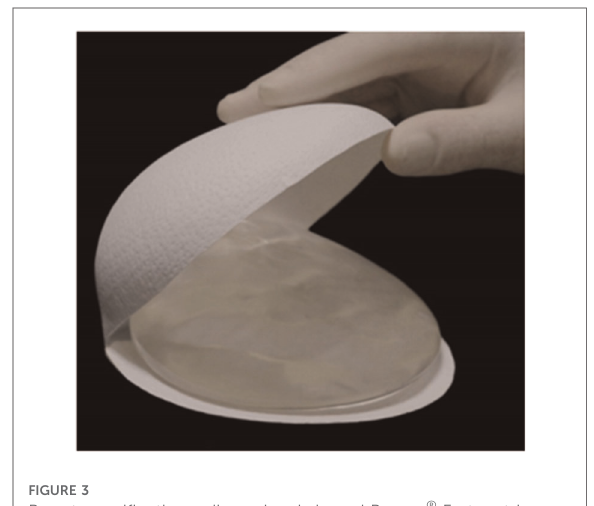
FIGURE 3 Breast-speci fi c, three-dimensional shaped Braxon ® Fast